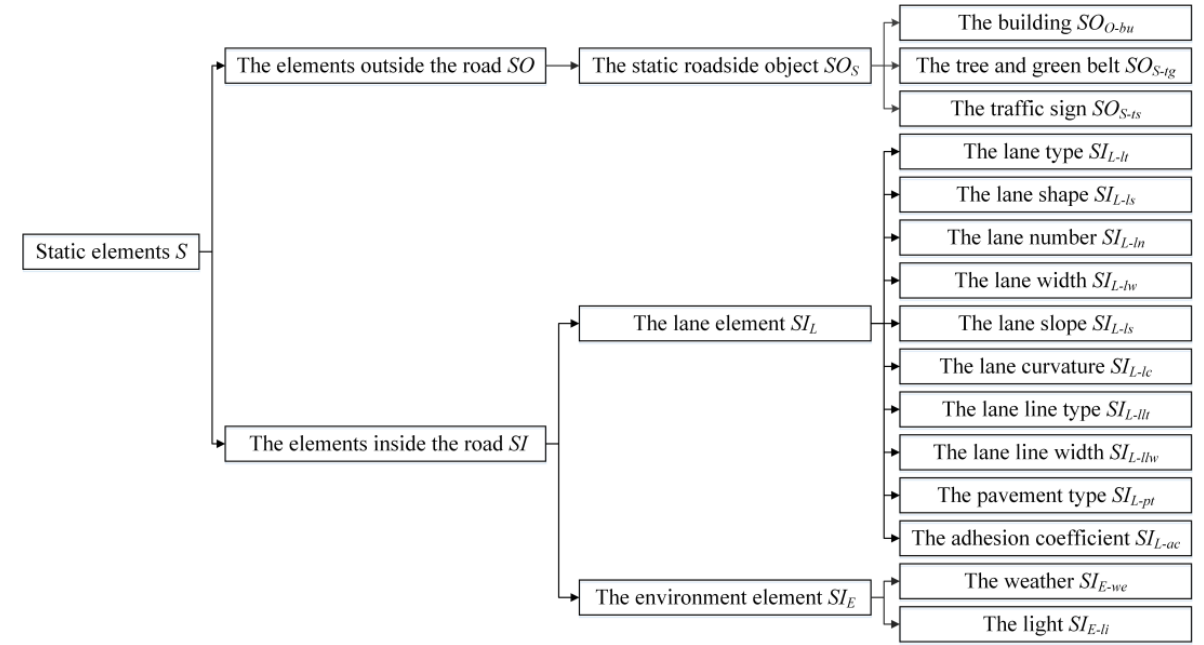
Figure 3. The classification of static elements.